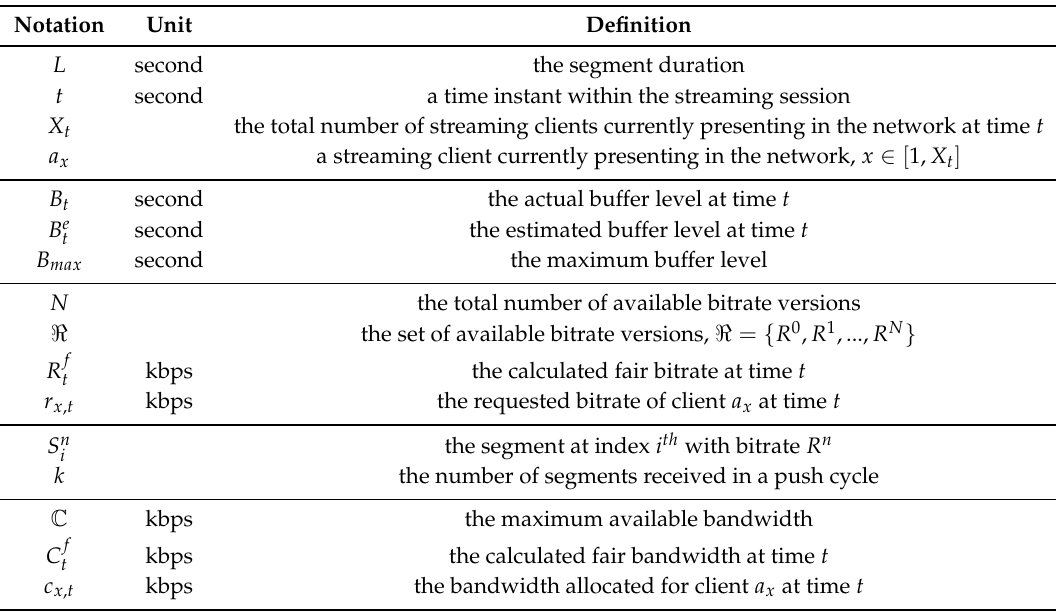
Table 1. Notations and definitions used in this